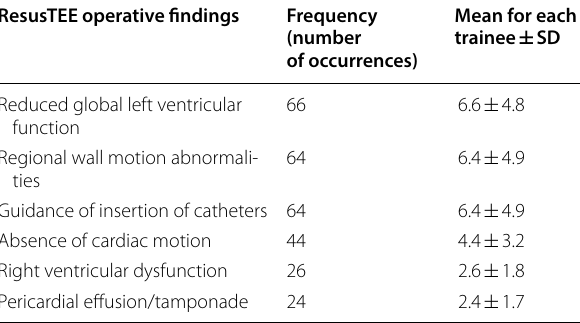
Table 2 ResusTEE operative findings during the hands-on